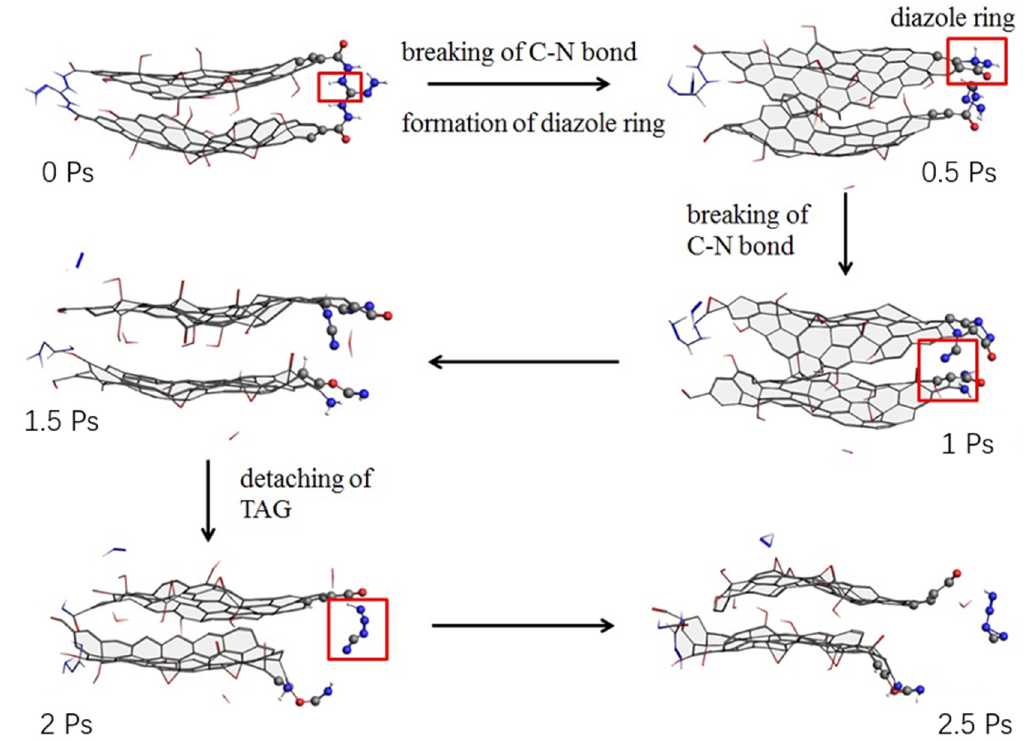
Figure 12. Molecular evolution of GO triaminoguanidine. Reprinted from ref. Figure 13. Molecular evolution of GO triaminoguanidine.